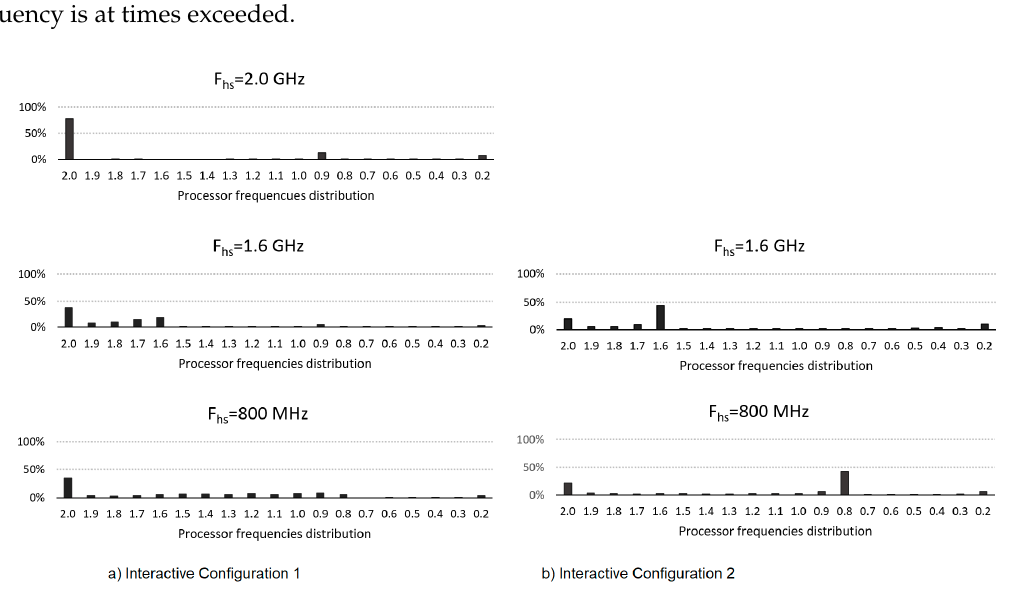
Figure 10. Evolution of energy consumption for the interactive governor for configurations 1 and 2, using different values of F hs , compared to consumption using Ondemand and Performance . 4. Conclusions and Future Work The use of smart sensors in the field of industry, in particular in near sensor computing or fog computing, has great potential for use in the future. The requirements determined by industry 4.0 require the flexibility of the sensors so that they can be used for different types of tasks. Multicore architectures, whether big.LITTLE or not, allow the field of use of these devices to be extended. Thus, with respect to a cloud computing solution using Performance , savings of 178% are achieved for vid1, 101% for vid2, and 21% for vid3. Thus, compared to a cloud computing solution, a high energy saving is achieved, a key aspect in this field, although it depends on the system load. As for the solution based on edge computing, the default configurations are designed for smartphones. The use of the Interactive governor allows different computing loads to be dealt with efficiently. If the parameters of this governor are also set taking into account the load with which they have to work at a given time in an application in the 4.0 industry, it is possible to significantly improve energy savings while